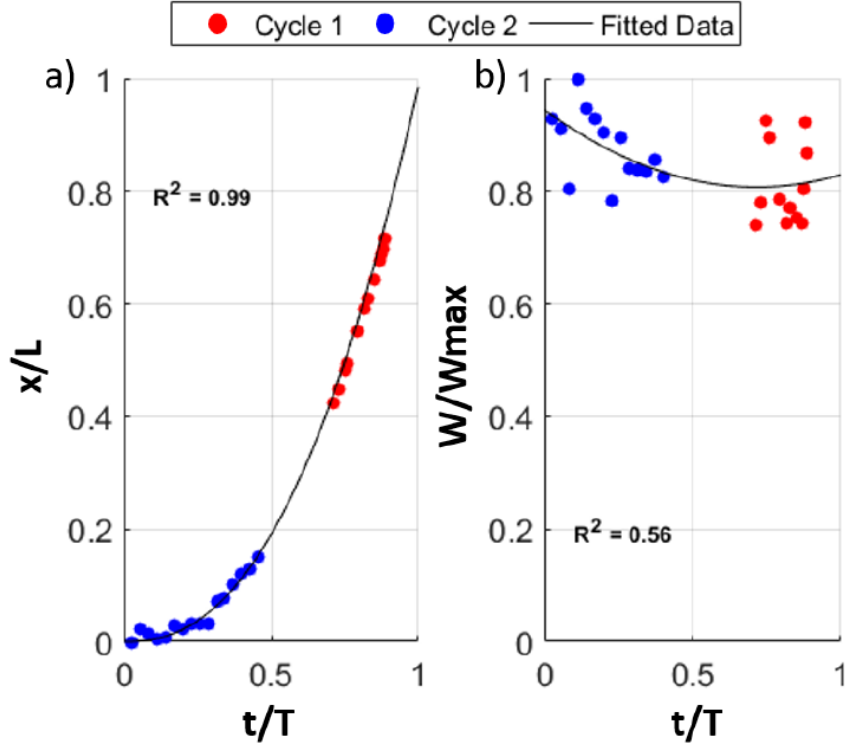
Figure 6. ( a ) Sand spit tip’ positions for cycle 1 (1984–2003; red) and cycle 2 (2003–2020; blue) derived from CoastSat tool [44] and fitted data expressed as Equation (4). ( b ) Sand spit averaged width evolution between transect Y = 1.7705 × 10 6 Y UTM (28) and 1 km South with its fitted data expressed as Equation (5)